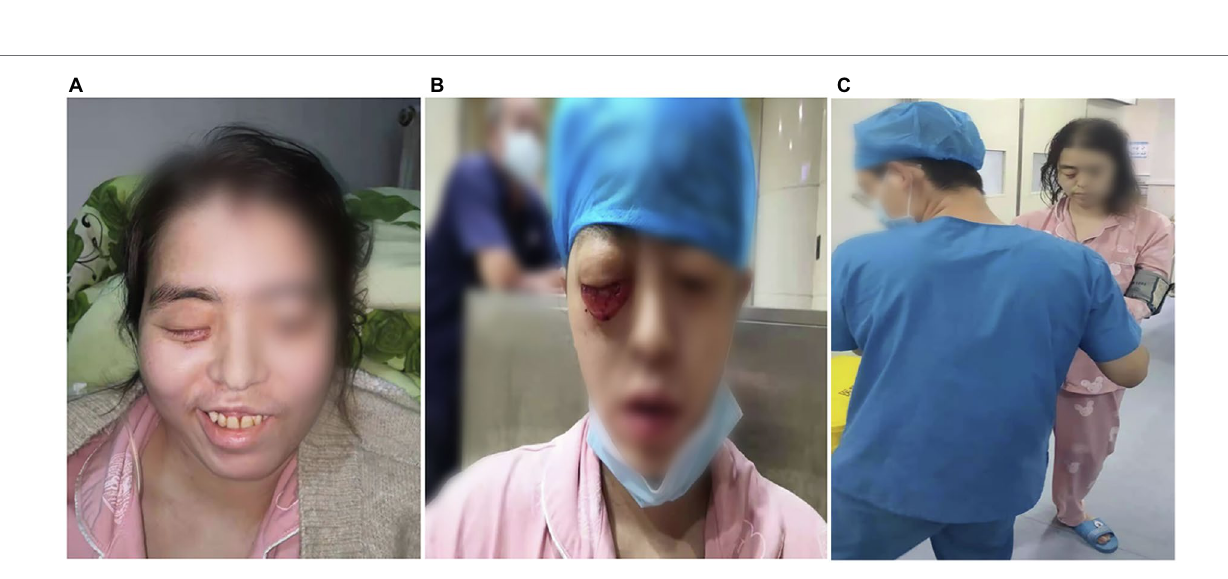
FIGURE 2 | Facial features and limb muscle strength of the patient. (A) On admission, the patient presented with facial paralysis and askew mouth. After treatment, the conjunctival swelling had reduced. (B) On admission, the patient presented with right eye proptosis and fixation, conjunctival hyperemia and edema, and drooping eyelids (C) after 67 days of treatment, the patient’s limb muscle strength showed grade